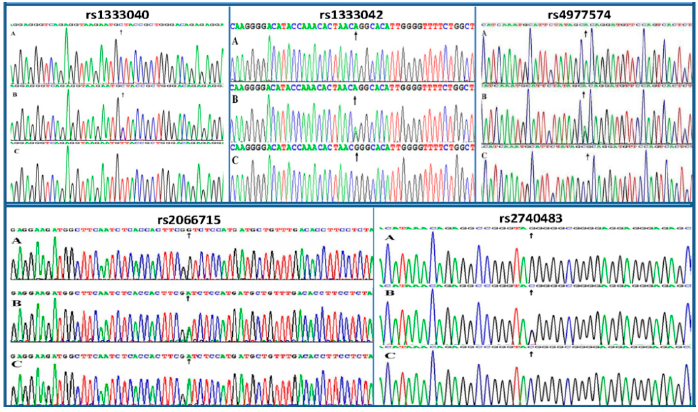
Figure 2. A part of the nucleotide sequences of the rs1333040, rs1333042, rs4977574, rs2066715